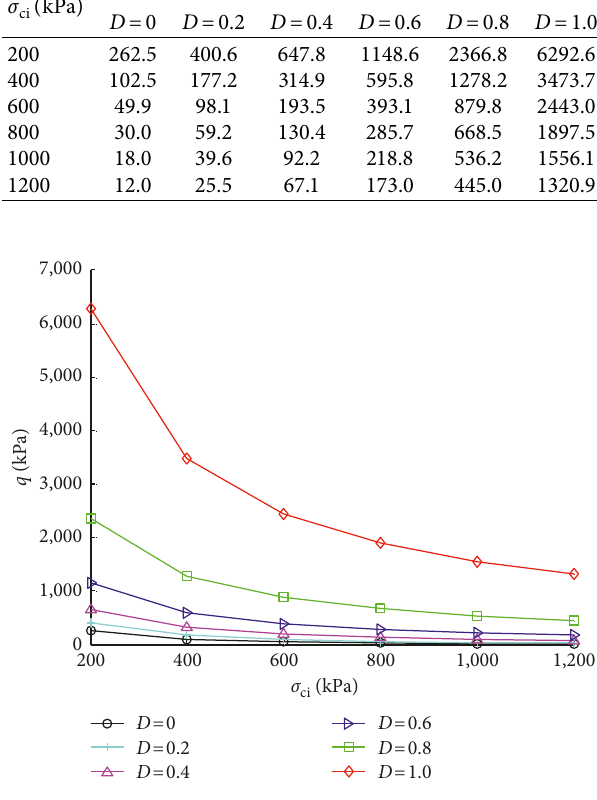
Figure 10: Effect of σ and D on the surrounding rock pressure q . ci